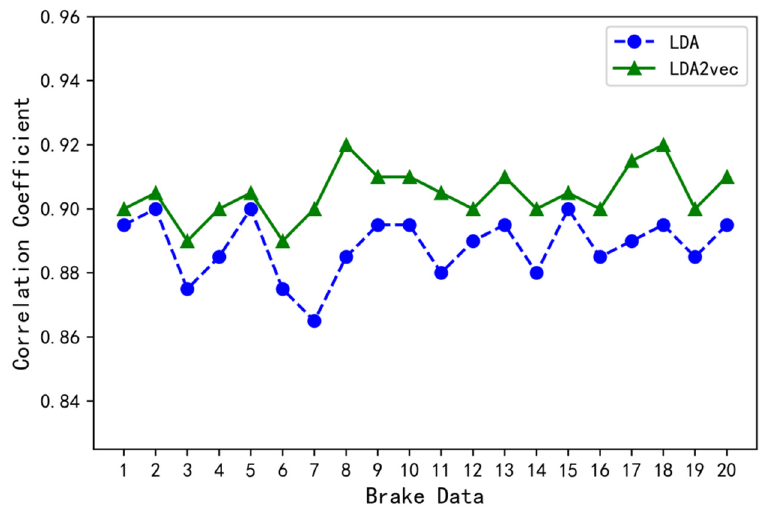
Figure 7. Correlation coefficients between the reconstructed and original braking data in the LDA and LDA2vec models. and LDA2vec models.